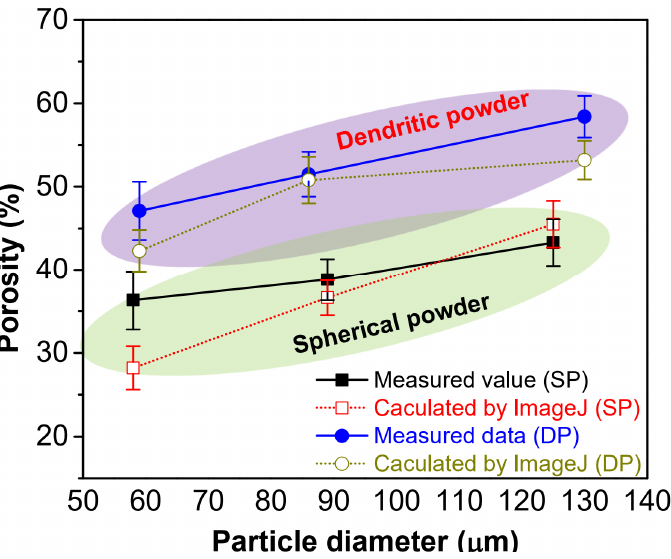
Figure 9. Total porosity and open porosity of porous copper samples using spherical and dendritic powders.